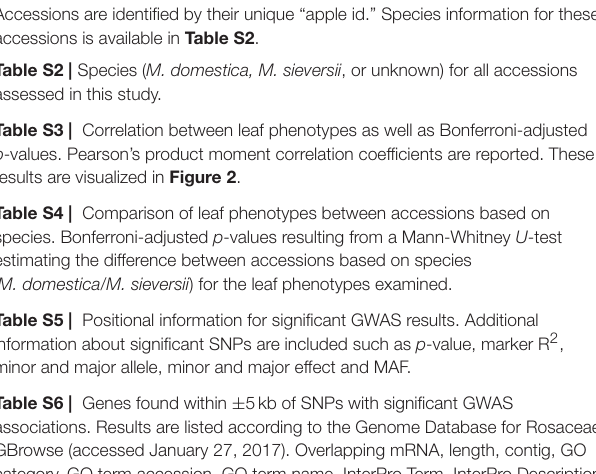
Table S5 | Positional information for significant GWAS results. Additional information about significant SNPs are included such as p -value, marker R 2 , minor and major allele, minor and major effect and MAF. Table S6 | Genes found within ± 5kb of SNPs with significant GWAS associations. Results are listed according to the Genome Database for Rosaceae GBrowse (accessed January 27, 2017). Overlapping mRNA, length, contig, GO category, GO term accession, GO term name, InterPro Term, InterPro Description, and NCBI sequence with Max Score when BLASTed using NCBI are